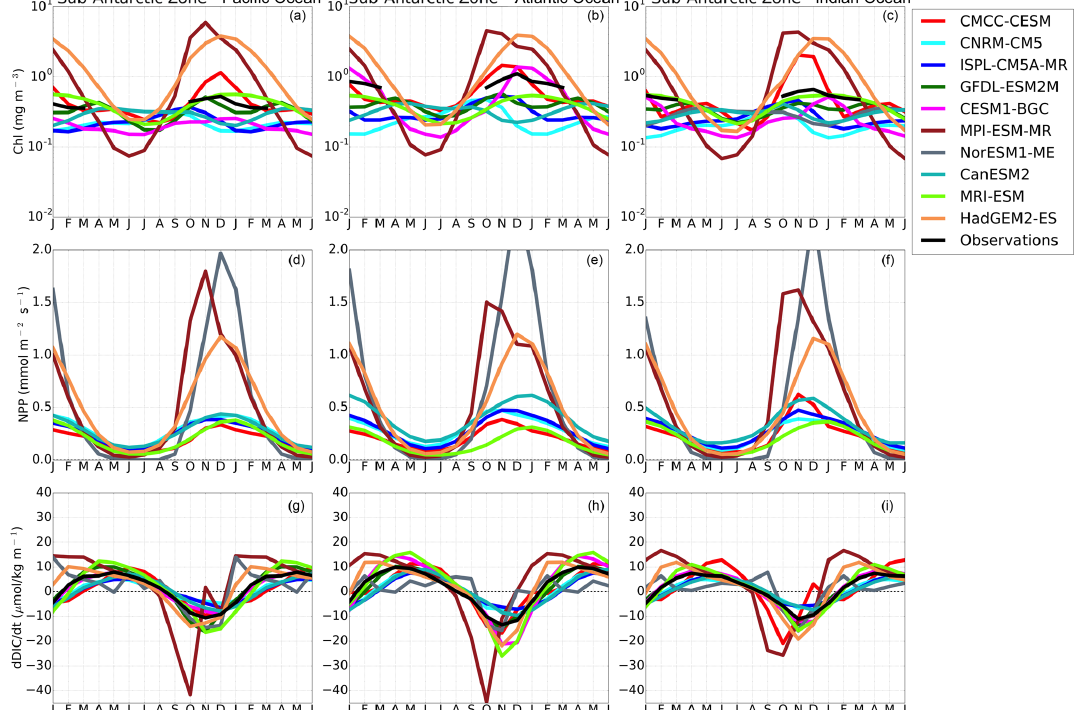
Figure 8. The seasonal cycle of chlorophyll (mgm − 3 ) , net primary production (mmolm − 2 s − 1 ) and the surface rate of change of DIC (µmolkg − 1 month − 1 ) in the Sub-Antarctic Zone of the Pacific Ocean (first column), Atlantic Ocean (second column) and Indian Ocean (third